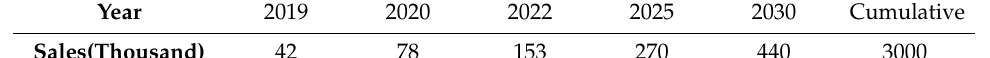
Table 20. The predicted number of EV in South Korea excluding Jeju Island by 2030.